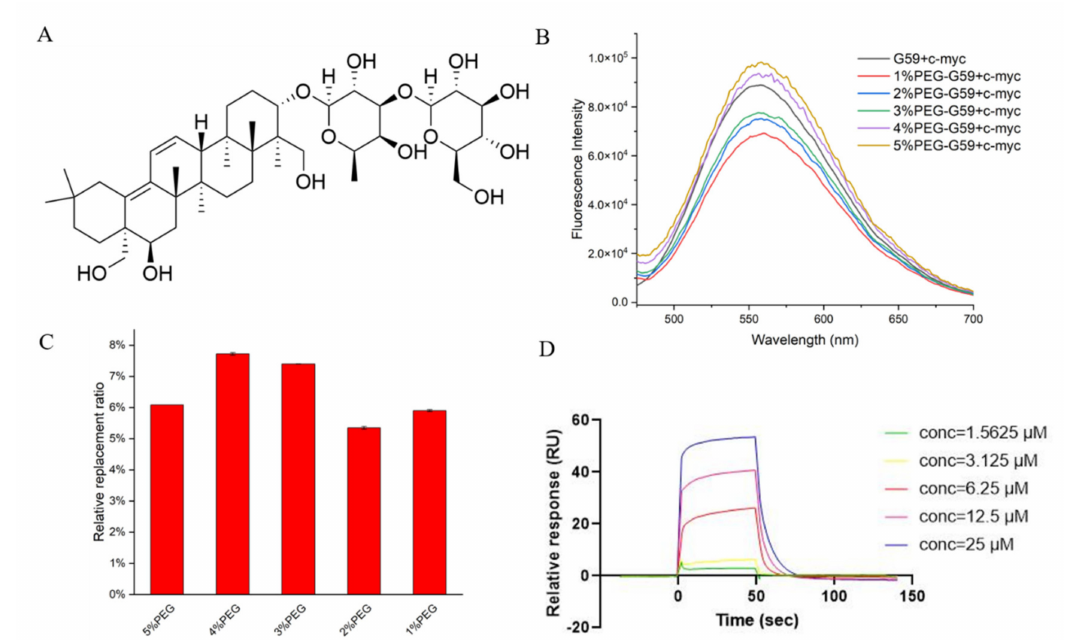
Figure 6. Studies for G59 replacement by natural product S857 upon binding with c-myc promoter i-motif. ( A ) Chemical structure of S857 . ( B ) Fluorescent spectra for mixture of 1 µ M G59 and 2 µ M c-myc i-motif in 1 × BPES buffer at pH 5.5, or 1 × BPES buffer at pH 6.5, with an increasing amount of PEG as the crowding agent. ( C ) Relative G59 replacement ratio for natural product S857 in 1 × BPES buffer at pH 6.5, with an increasing amount of PEG as the crowding agent. ( D ) The binding affinity of S857 to c-myc i-motif was analyzed using SPR in MES